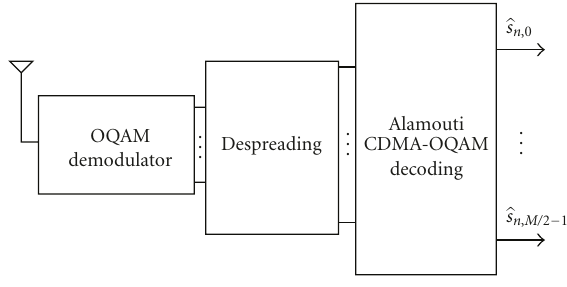
Figure 6: An Alamouti CDMA-OFDM/OQAM receiver.